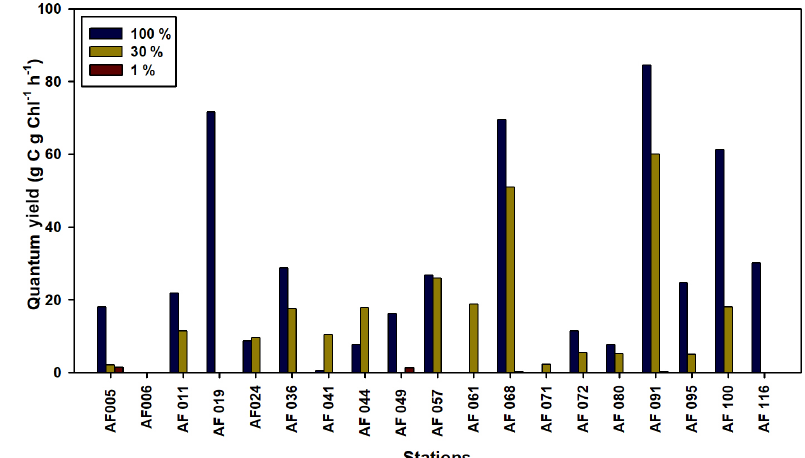
Figure 8. Quantum carbon yield of small phytoplankton in the sampling locations.